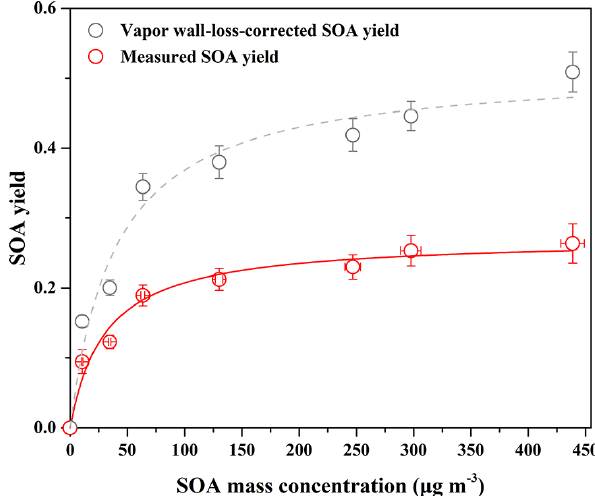
Figure 1. SOA yield as a function of SOA mass concentration ( M o ) for guaiacol photooxidation in the presence of NO x at different gua- iacol concentrations. The lines were fit to the experimental data us- ing a one-product model. Values of α and K om ,i used to generate the solid line were (0 . 27 ± 0 . 01) and (0 . 033 ± 0 . 008), and their values for the dashed line were (0 . 52 ± 0 . 03) and (0 . 025 ± 0 . 006), respec-